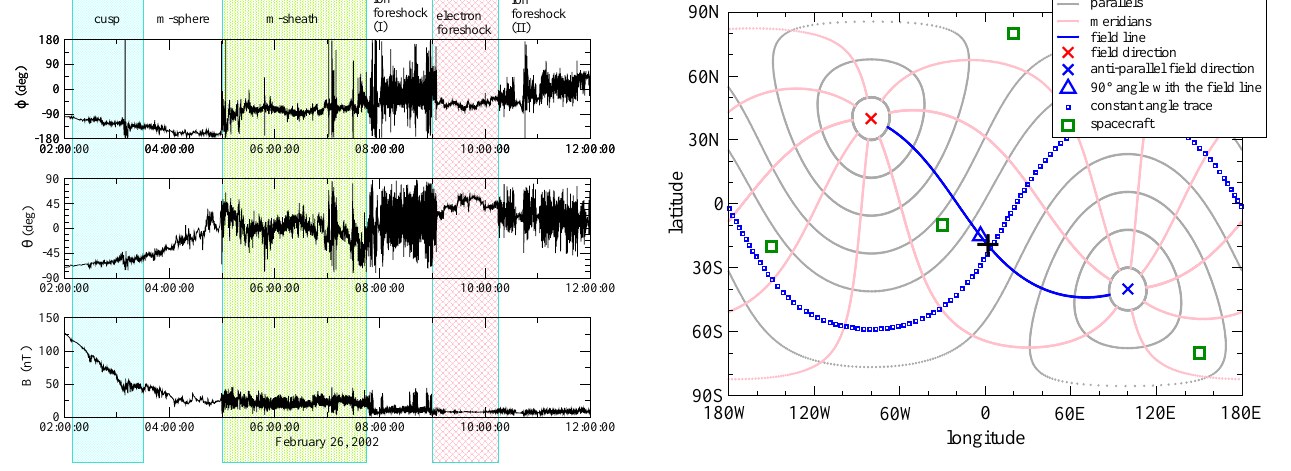
Fig. 3. The magnetic field in spherical GSE coordinates measured by Cluster 1 on 18 February 2002. Different regions are marked by colored rectangles.